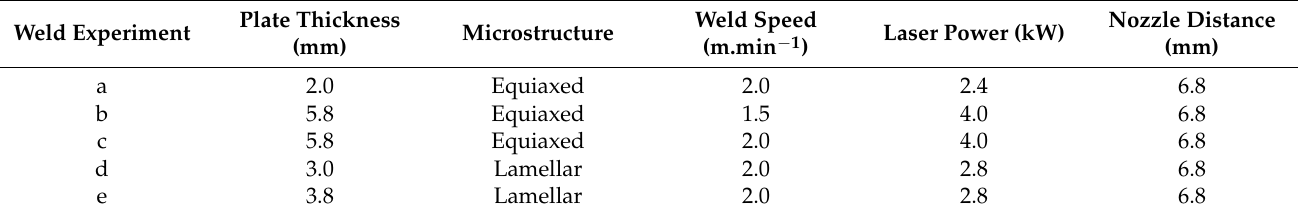
Table 2. Chemical compositions of the 2.0 and 5.8 mm equiaxed plates and the 3.0 and 3.8 mm lamellar plates. Plate Weld Experiment